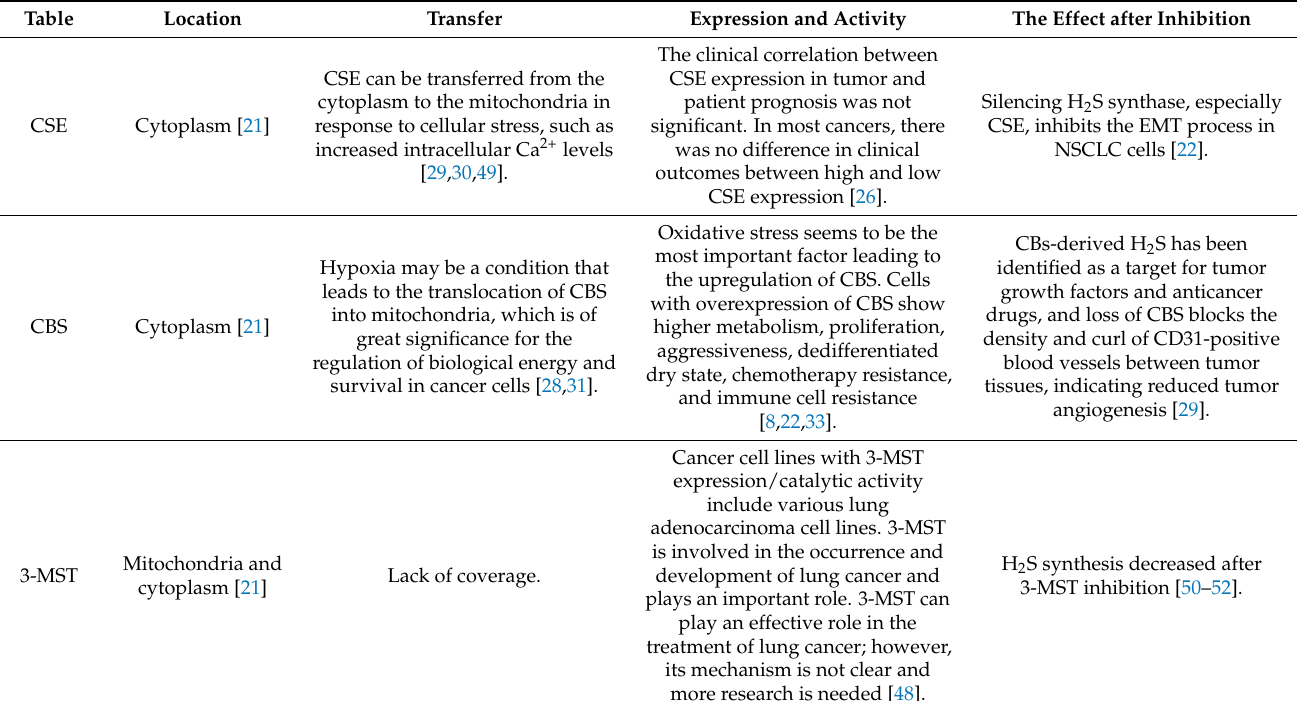
Table 1. Abbreviations: CSE: cystathionine γ -lyase; EMT: epithelial–mesenchymal transition; H 2 S: hydrogen sulfide; CBS: cystathionine β -synthase; NSCLC: non-small-cell lung cancer; 3-MST: 3- mercaptopyruvate